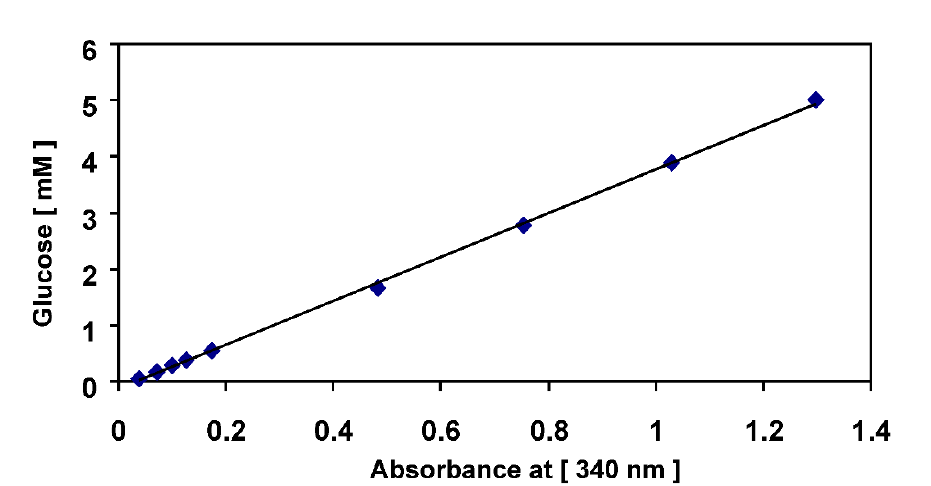
Figure 15. Calibration curve for the glucose concentration. Several glucose standards (0.05–5 mM) were analysed using an enzymatic kit assay (K-SUFRG). A calibration curve was obtained by plotting the glucose concentrations against their measured absorbance at 340 nm. The plotted values of absorbance are the average of three measured values with an average standard deviation of ±0.04.